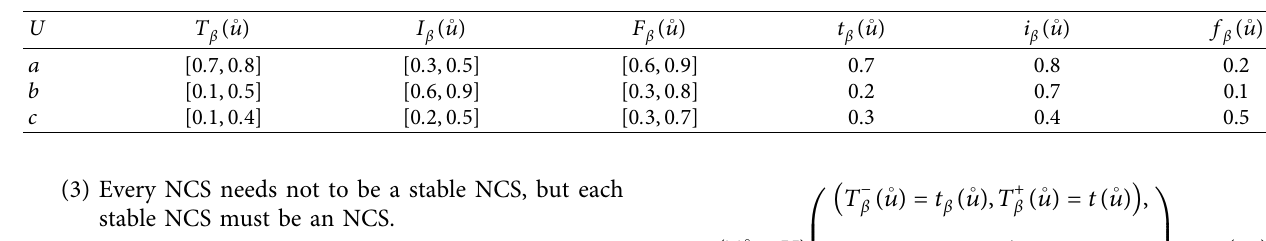
Table 7: Neutrosophic cubic set β of